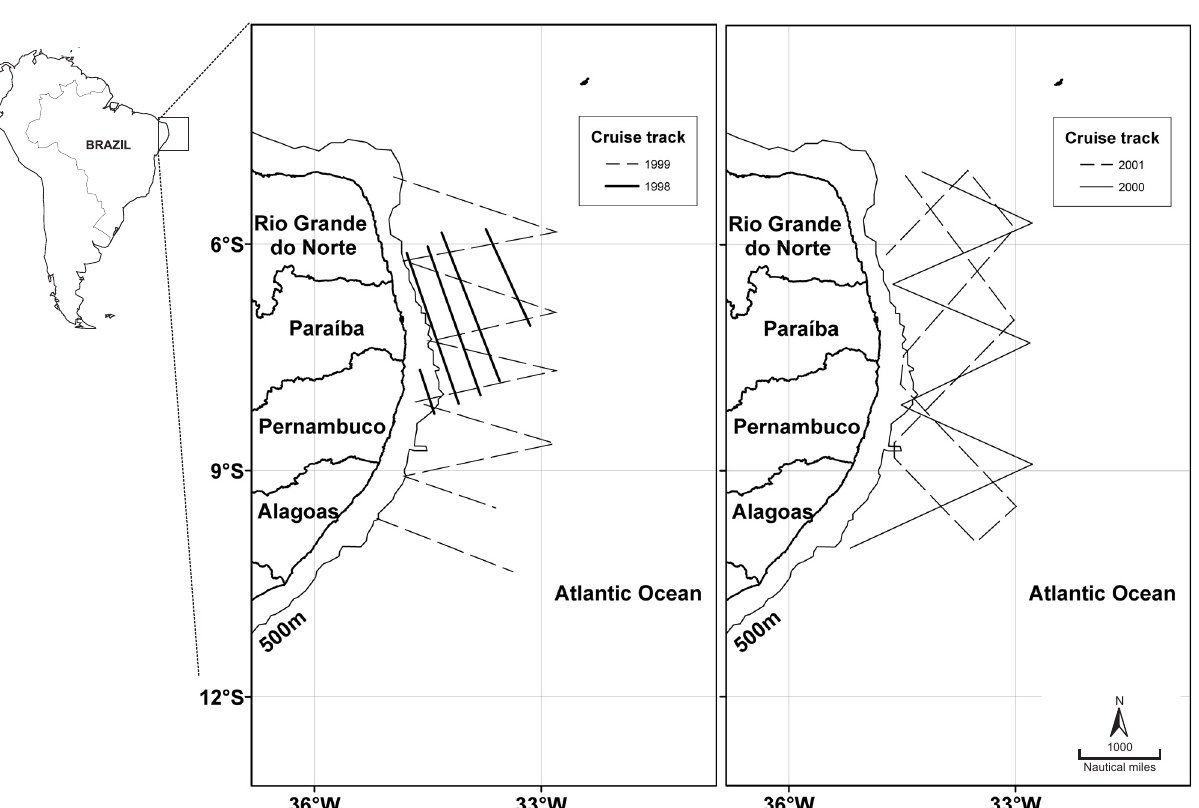
Figure 1. Cruise track design of sighting surveys conducted off northeastern Brazil between 1998 and 2001 by the Minke Whale Project